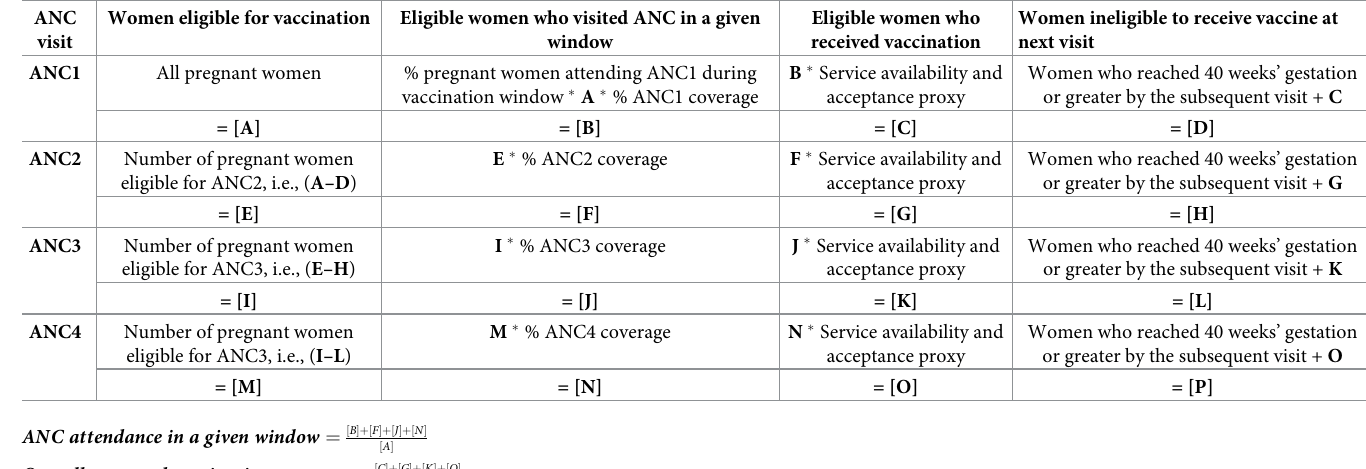
Table 1. Estimating maternal vaccination coverage by ANC